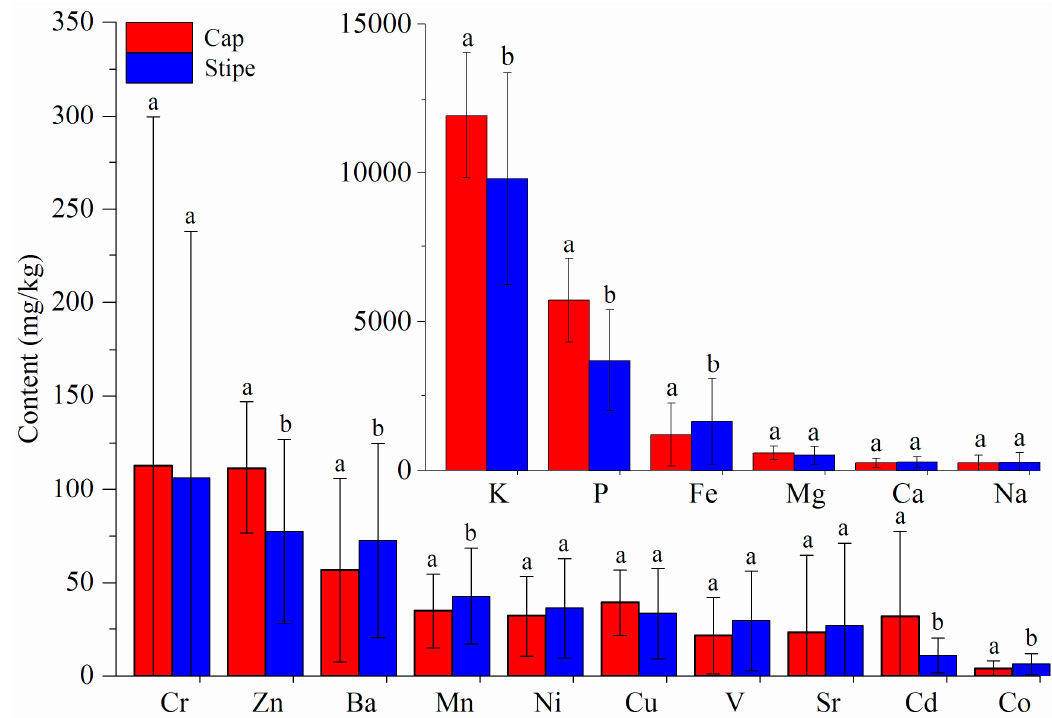
Figure 1. Comparison of 16 elements between cap and stipe. (Note: Different letters indicate a significant difference at P ≤ 0.05 according to Duncan test.)